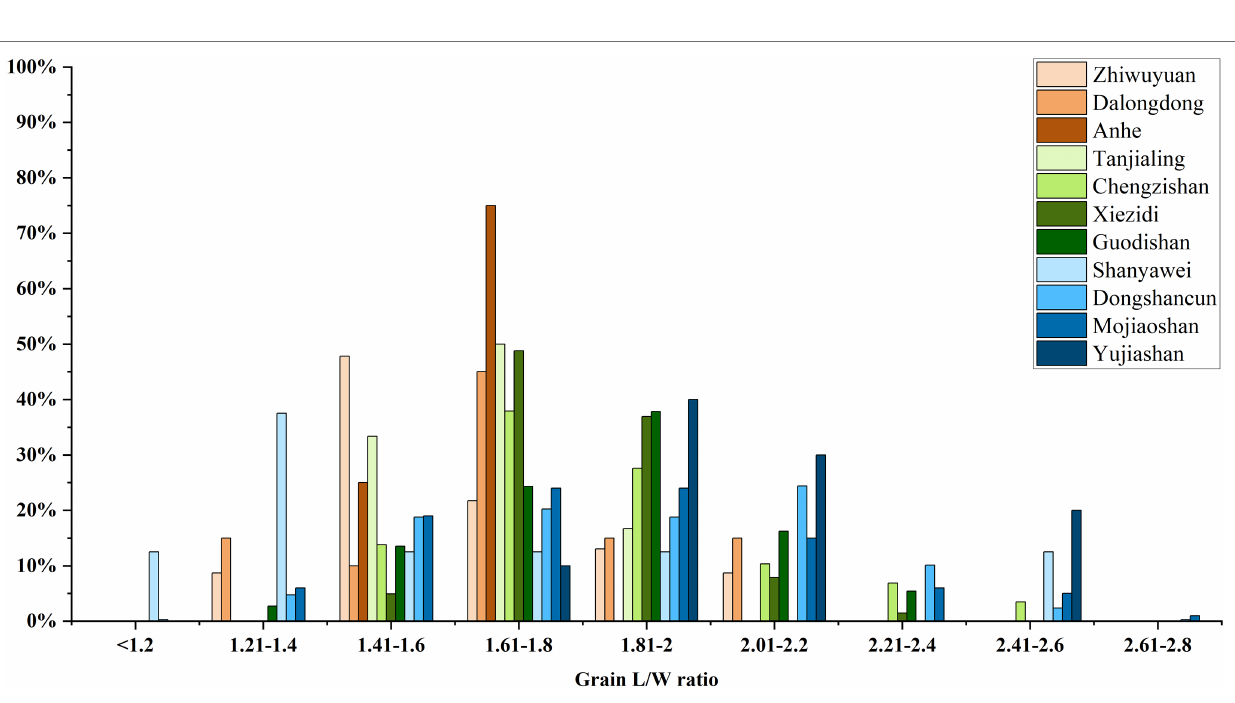
FIGURE 8 | Rice grain L/W ratio distributions of Zhiwuyuan, Dalongdong, and Anhe compared to remains from Neolithic sites of middle and lower Yangtze